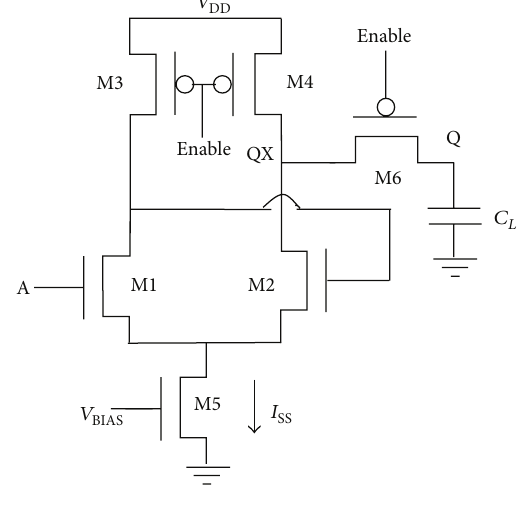
Figure 4: Proposed topology